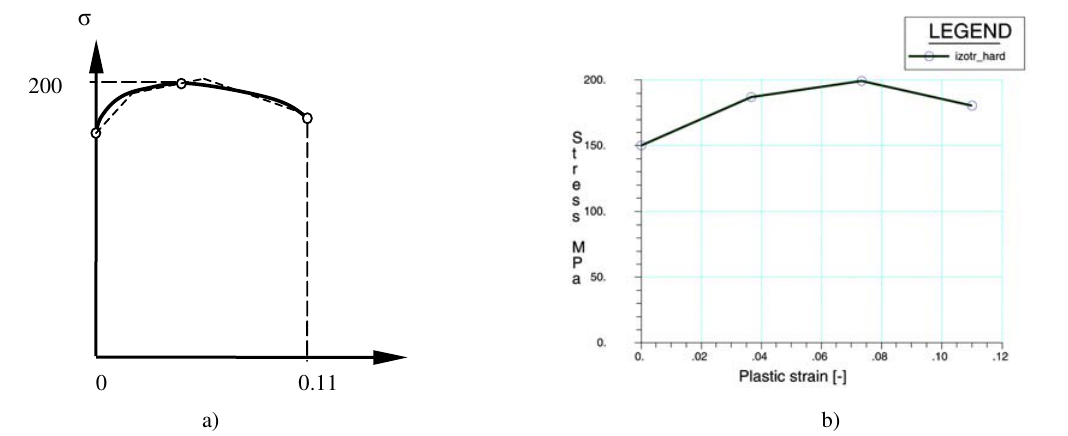
Fig 3. A plot of stress vs. plastic strain for the alloy PA-20 (a) and the discrete characteristic of this material